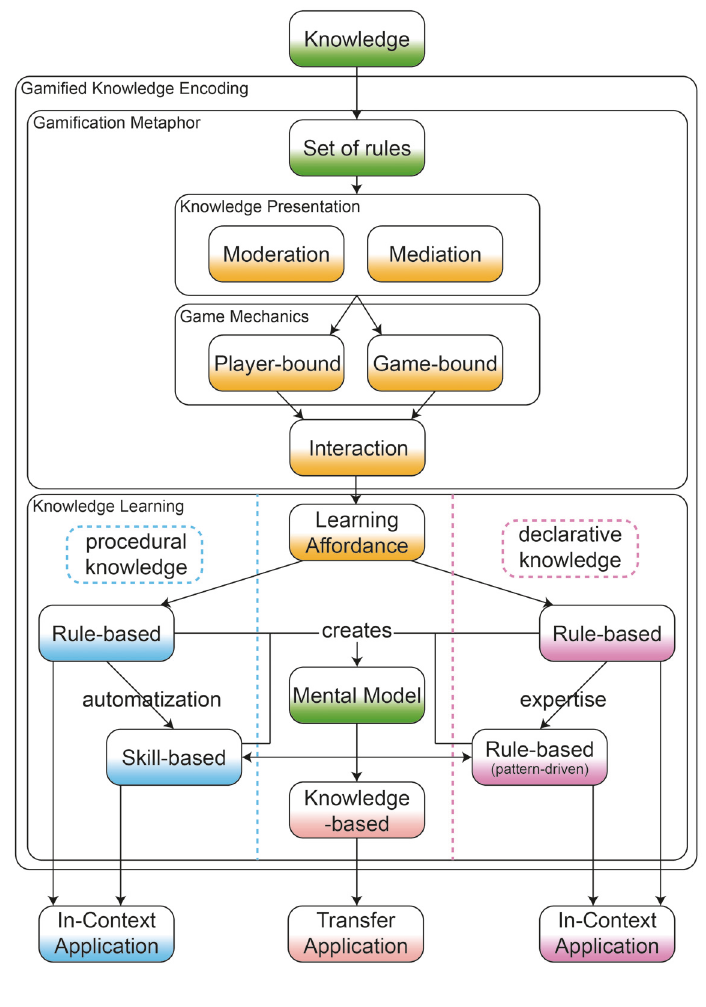
Figure 1: The Gamified Knowledge Encoding describes the process of knowledge encoding and learning using GMs. The knowledge gets segmented into coherent sets of rules which are mapped as game rules to interacting GMs. The interaction between these GMs creates a learning affordance for the encoded learning content. This initiates the theoretically grounded learning